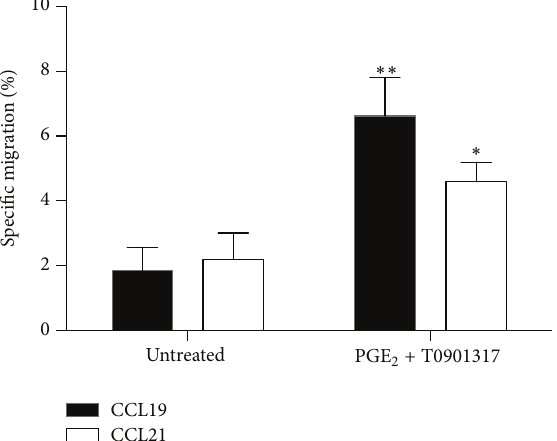
Figure 3: Freshly isolated monocytes migrate toward the CCR7-specific ligands CCL19 and CCL21. Chemotaxis assays using 300 ng/mL CCL19 and CCL21 were performed using human monocytes incubated in the presence or absence of 1 𝜇 M PGE 2 and 1 𝜇 M T0901317 for 48 h. Data represent the means of three different experiments. Data represent mean ± SD of three independent experiments. ∗ 𝑝 < 0.05 , ∗∗ 𝑝 < 0.01 compared to untreated